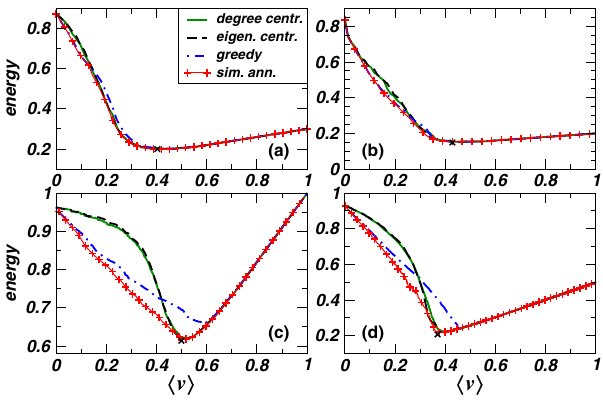
FIG. 15. Comparison between several immunization methods for the SIR model on four real-world networks: (a) social network in a community of dolphins (parameters q ¼ 0 . 1 , p ¼ 0 . 5 , μ ¼ 0 . 3 , ϵ ¼ 1 ), (b) network of characters of Les Misérables (parameters q ¼ 0 . 1 , p ¼ 0 . 5 , μ ¼ 0 . 2 , ϵ ¼ 1 ), (c) the Socio- patterns contact network ( q ¼ 0 . 1 , p ¼ 0 . 5 , μ ¼ ϵ ¼ 1 ), (d) friendship network in a U.S. high school ( q ¼ 0 . 1 , p ¼ 0 . 5 , μ ¼ 0 . 5 , ϵ ¼ 1 ). The energy as a function of h v i is shown, for immunization sets obtained using degree centrality (green line), eigenvector centrality (black dashed line), the greedy algorithm (blue dot-dashed line), and fixed-density simulated annealing (red vertical crosses). The optimal points found by Max-Sum are indicated by black crosses.